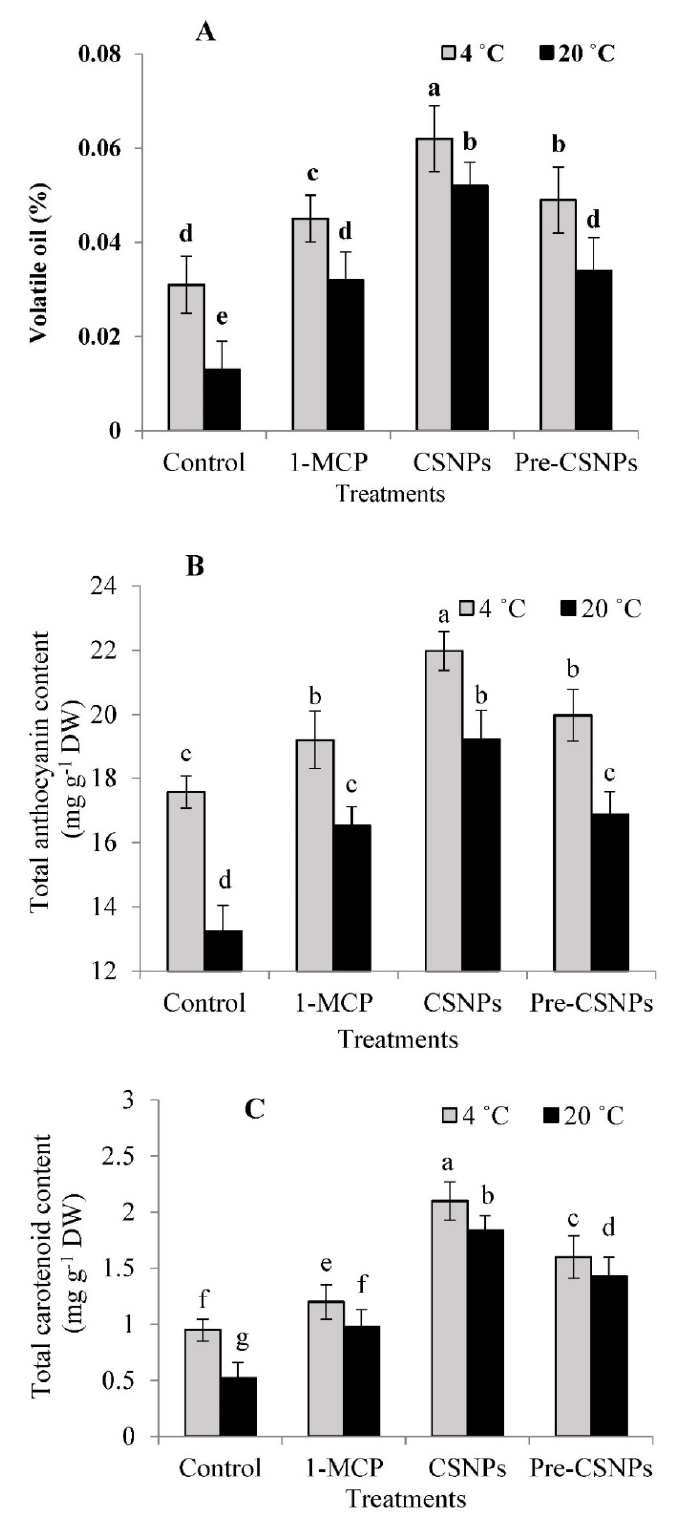
Figure 2. Essential oil percentage ( A ), anthocyanin content ( B ) and carotenoids content ( C ) of damask rose flowers stored at 4 or 20 °C and treated with 1-MCP and pre- and post-chitosan nanoparticles (CSNPs). Values are the means ± SE of two investigations ( n = 8). Columns with different letters are statistically different at p ≤ 0.05.